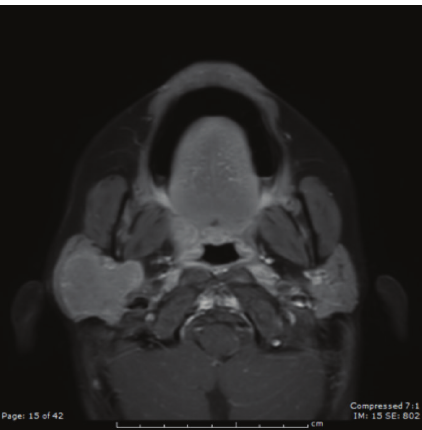
Figure 1: Axial T1 weight MRI (after contrast) shows a homoge- neous isointense lesion.